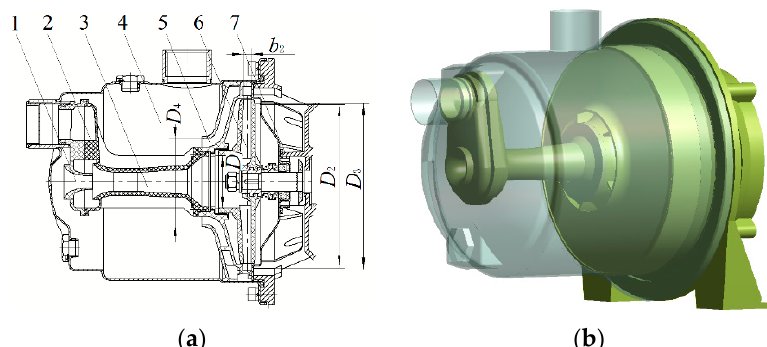
Figure 1. Structural diagrams of the model pump. ( a ) Two-dimensional structure diagram; ( b ) Three-dimensional structure diagram. 1: Ejector nozzle; 2: Ejector; 3: Pump chamber; 4: Ejector tube; 5: Guide vane; 6: Impeller; 7: Pump cover.